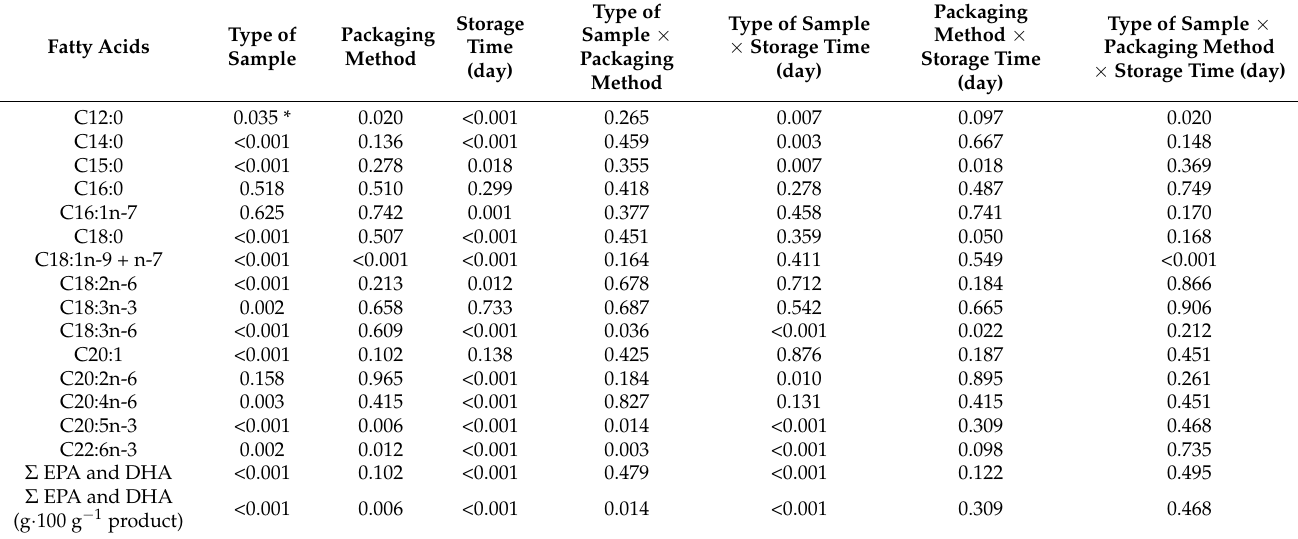
Table 4. The effects of interactions between selected variables (type of sample, packaging method, storage time) and their influence on the fatty acid